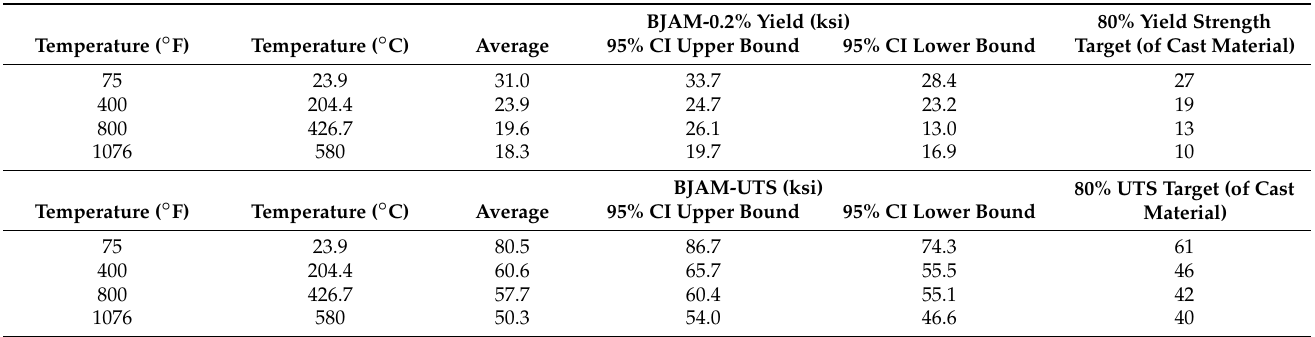
Figure 6. ( a ) Summary of Yield Strength of the Binder Jet coupons over a temperature range of 24– 580 °C (75–1076 °F), compared to cast properties of SS316L material available from the literature [15,16] and ( b ) summary of ultimate tensile strength of Binder Jet coupons. Table 3. Summary of the Yield Strength and Ultimate Tensile Strength values of the Binder Jet SS316L material, compared with the relevant properties of the cast material from the literature. Note that the lower 95% confidence interval of the BJ data meets or exceeds.